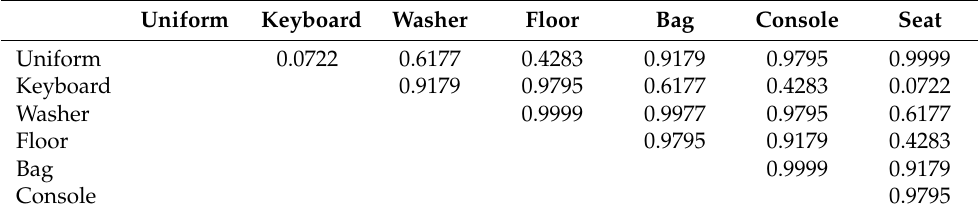
Table 6 reports p -values obtained from Tukey–Kramer comparisons of the detected bacteria between the fire departments. E. faecalis was most likely to be detected on surfaces at FD2 (seven occasions) than FD1 (one occasion). S. pneumoniae was more likely to